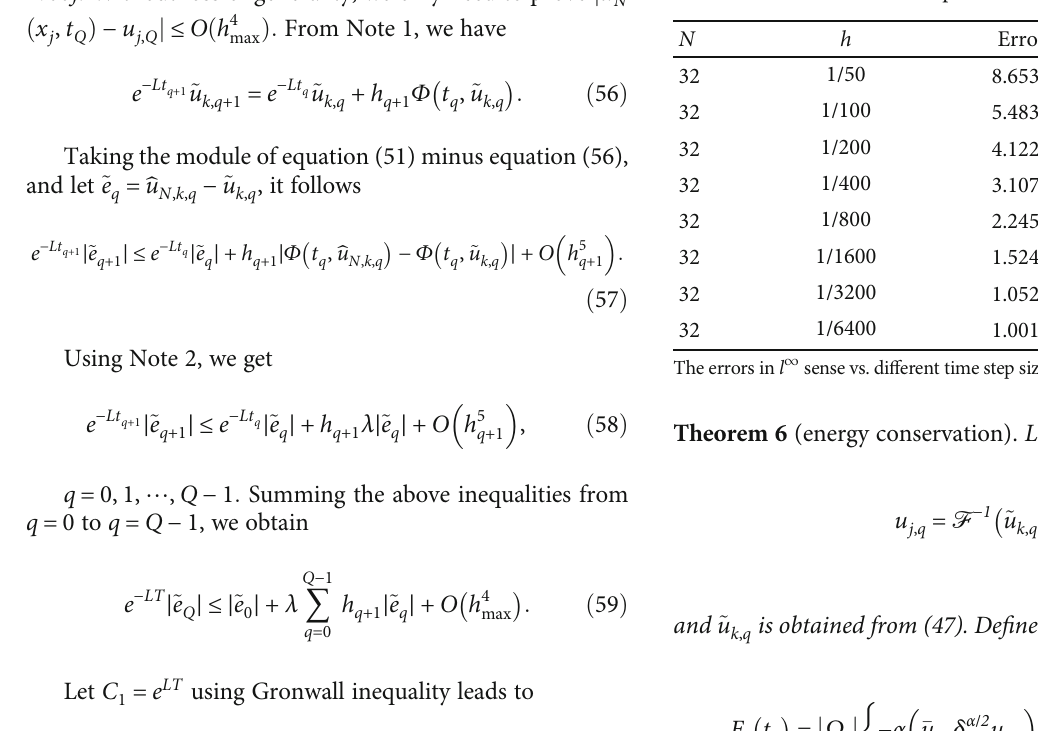
Table 4: Errors in temporal direction for Example 2.